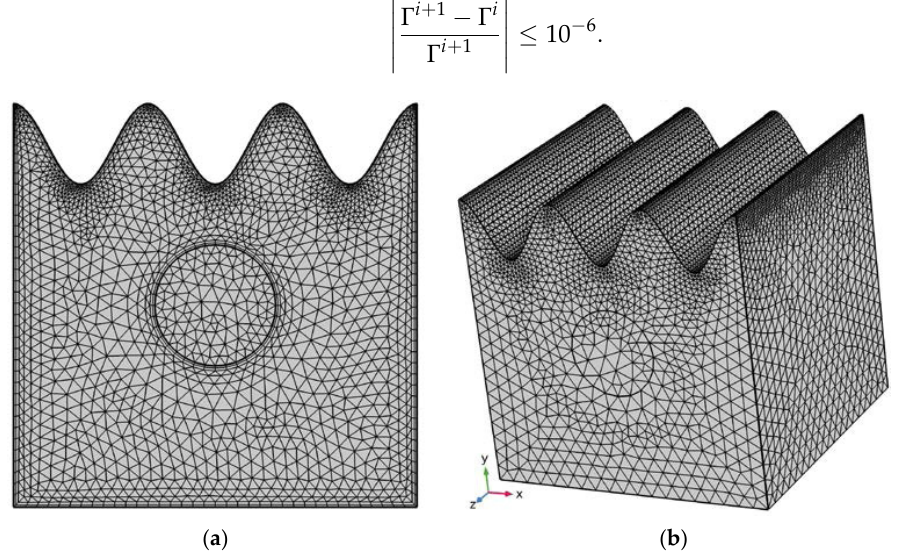
Figure 2. Grid-point distributions ( a ) 2D on XY -plane and ( b ) 3D.